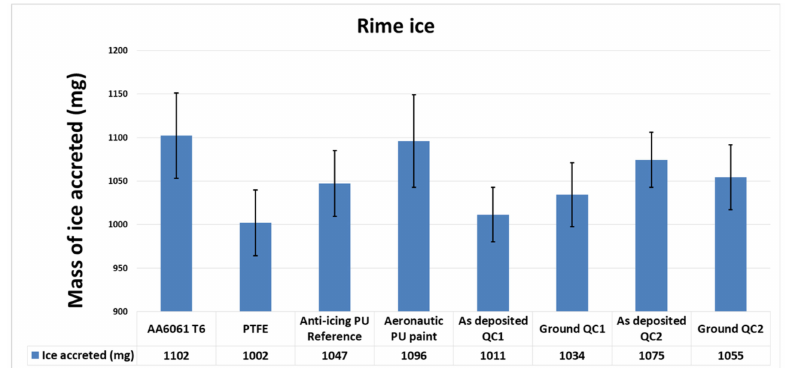
Figure 16. Ice accretion of all studied materials obtained under rime ice conditions.